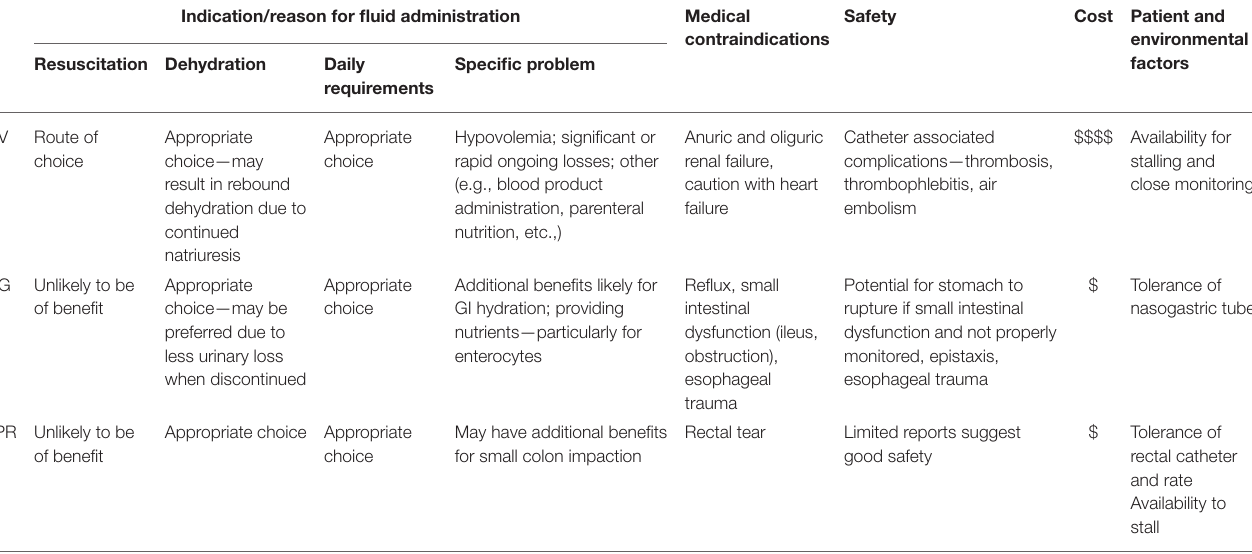
TABLE 1 | Factors influencing the choice of route of fluid administration to horses.